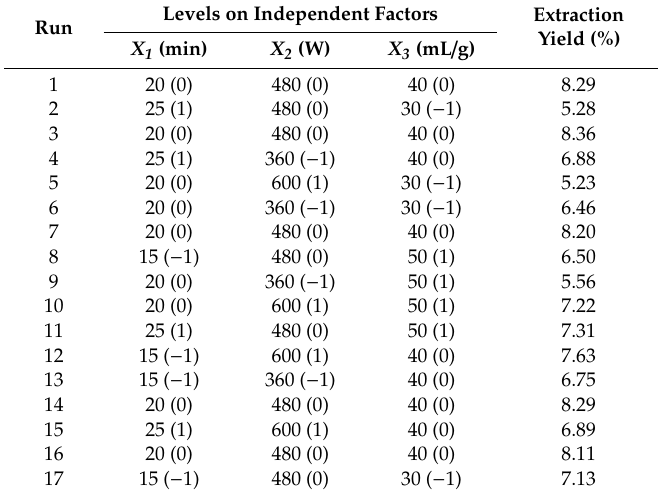
X 1 : extraction time; X 2 : ultrasonic power; X 3 : ratio of